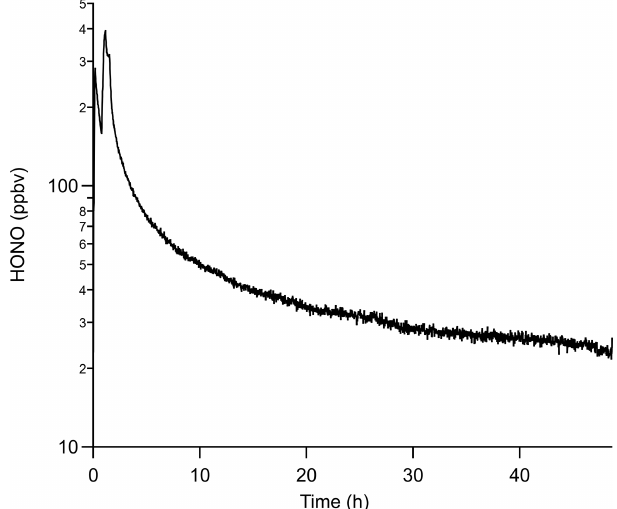
Figure 6. Mixing ratio of HONO produced from a NaNO 2 -coated annular denuder using PD-6c. Time zero is when HCl was first in- troduced to the annular denuder at 50% RH. Note that HONO mix- ing ratios are on a log